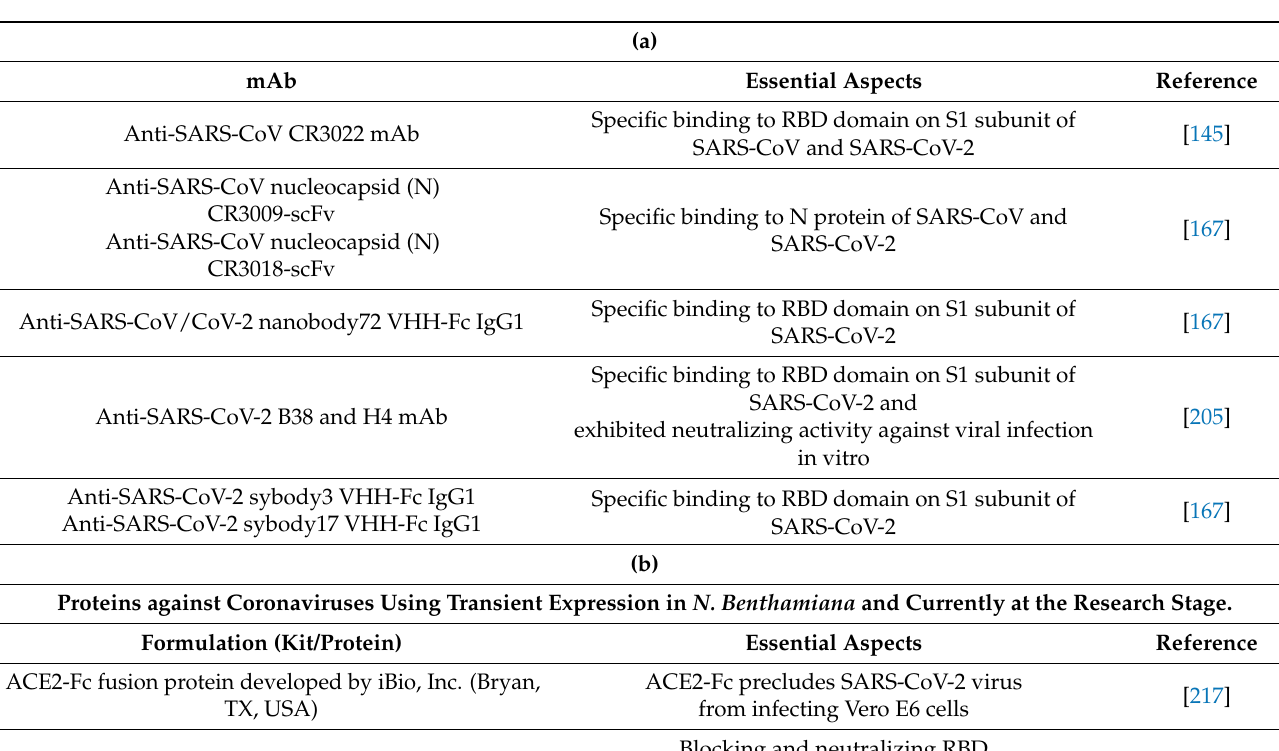
Table 3. ( a ) List of plant-produced anti-coronavirus mAbs generated using transient expression in N. benthamaina and currently at the research stage. ( b ) List of other therapeutic proteins and diagnostic